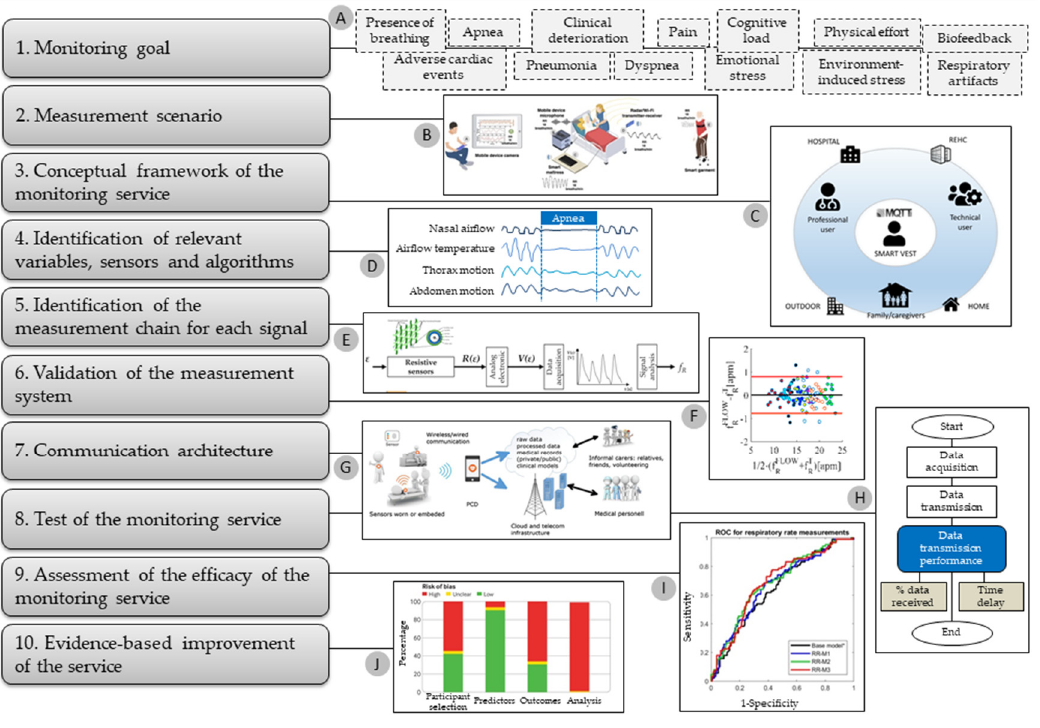
Figure 4. A conceptual framework for the development of respiratory monitoring services. The framework is composed of ten steps that are numbered and listed on the left-hand side of the figure. Each of the ten steps is accompanied by a graphical example reported on the right-hand side of the figure. Panel ( A ) reports the thirteen monitoring goals described in this review. The graph in panel ( B ) is reproduced from Massaroni et al. [5]. The graph in panel ( C ) is reproduced from Naranjo-Hernández et al. [157]. Panel ( D ) provides an example of the output of some of the sensors used to detect apnea events in sleep laboratories. The graph in panel ( E ) is slightly modified from Massaroni et al. [24]. The graph in panel ( F ) is slightly modified from Lo Presti et al. [290]. The graph in panel ( G ) is reproduced from Tomasic et al. [293]. Panel ( H ) provides an example of data transmission performance evaluation. The graph in panel ( I ) is slightly modified from Quinten et al. [116]. The graph in panel ( J ) is slightly modified from Gerry et al. [110].